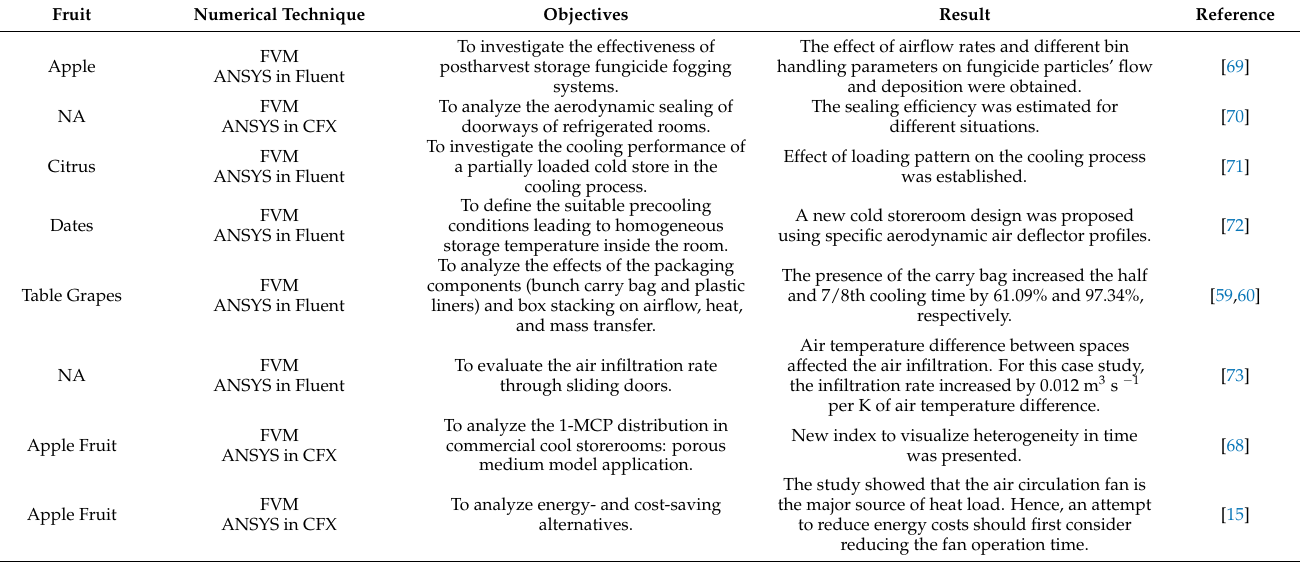
Table 3. Objectives, numerical techniques, and results of computational-fluid-dynamics-based analysis in cold storage room studies.